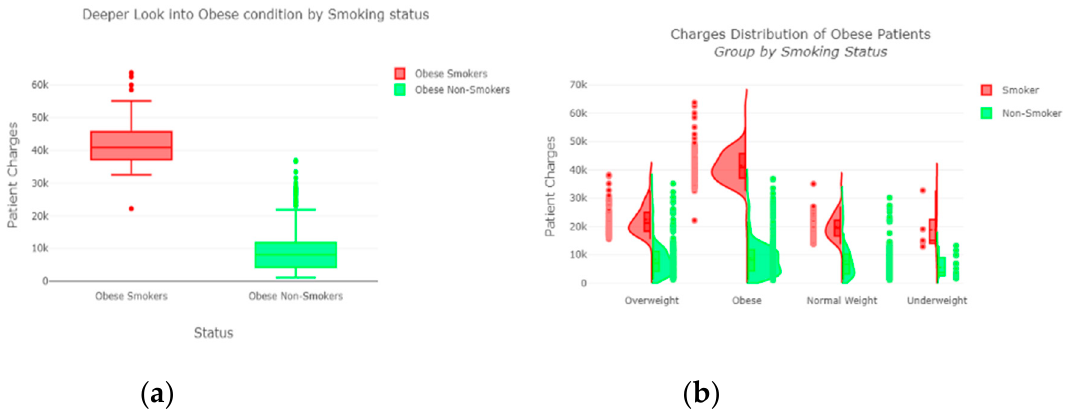
Figure 11. ( a ) Obese condition by smoking status; ( b ) distribution of obese patient group by smoking status. smoking